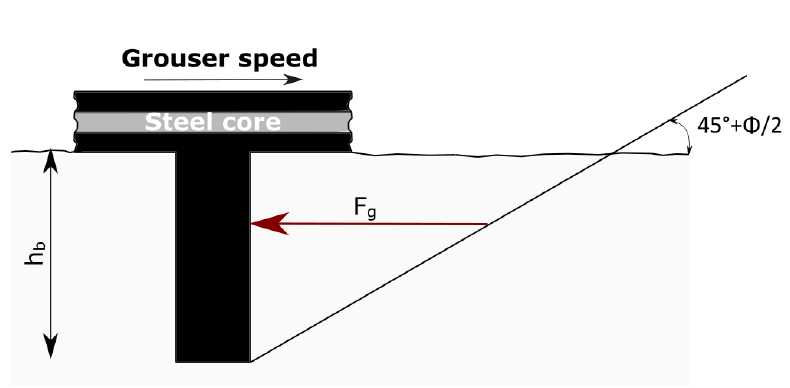
Figure 3. Interaction of a grouser with the